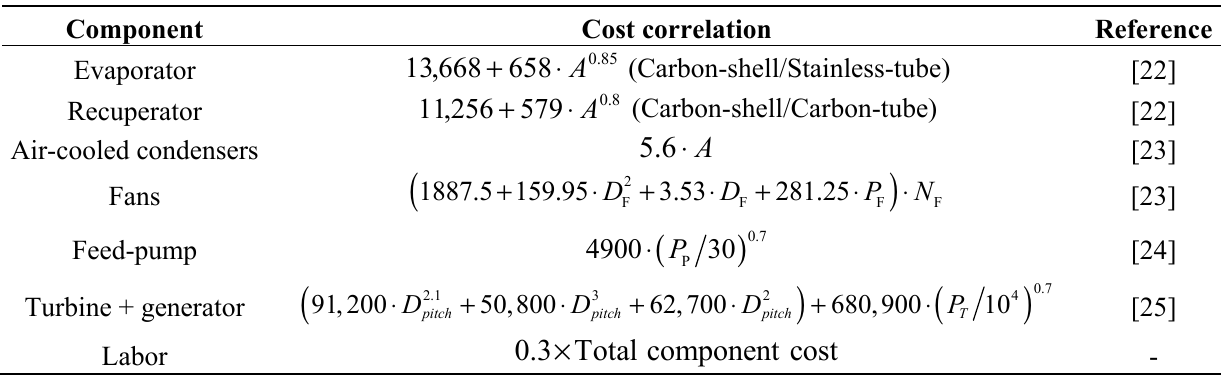
Table 3. Component cost as function of size.